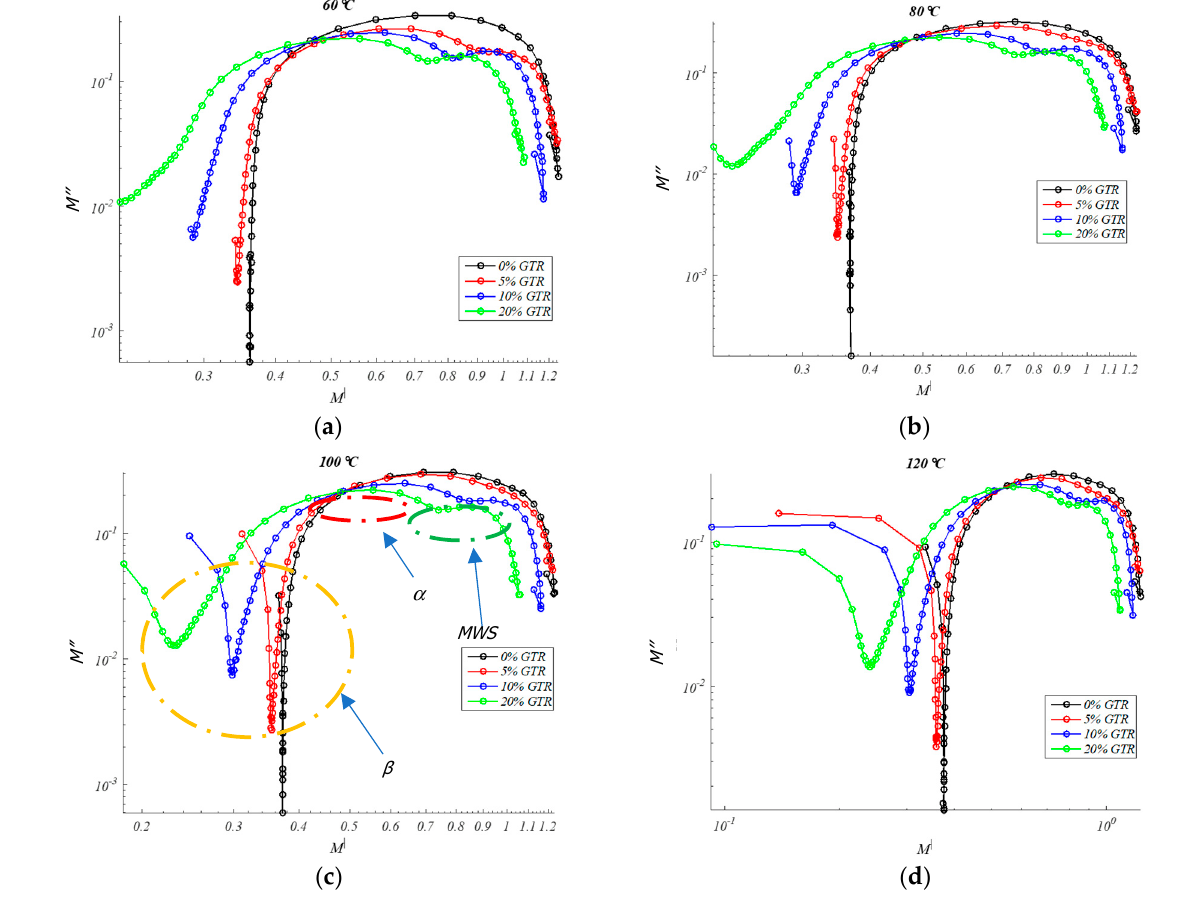
Figure 9. Argand diagram (M’’-M’) in EPDM/GTR composites: for 0%, 5%, 10%, 20% GTR amount, for: ( a ) 60 °C; ( b ) 80 °C; ( c ) 100 °C; ( d ) 120 °C.